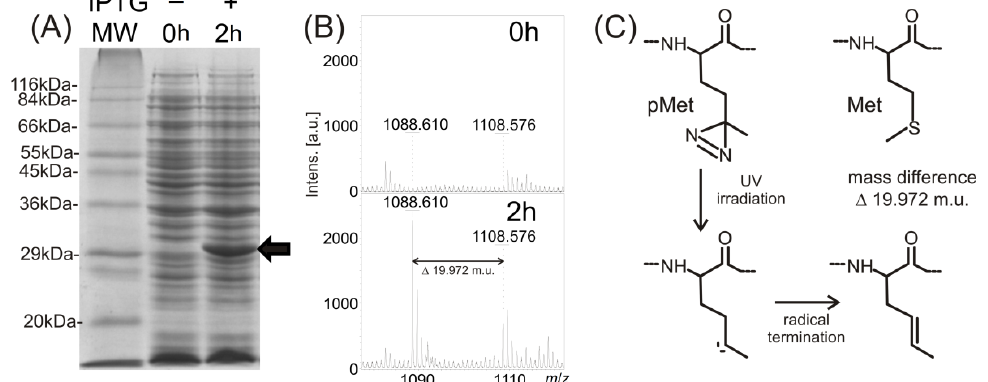
Figure 1. Monitoring of 14-3-3 ζ protein expression using 12% sodium dodecyl sulfate polyacrylamide gel electrophoresis (SDS-PAGE) ( A ); incorporation of the photo-labile analog of methionine by matrix-assisted laser desorption ionization-time of flight mass spectrometry (MALDI-TOF MS) ( B ), IPTG, β - D -1-thiogalactopyranoside; MW, molecular weight; a diagram of a reaction mechanism of photolysis ( C ). ( A ) SDS-PAGE of Sigma wide-range molecular weight standards, 14-3-3 ζ WT expression before induction (0 h) and after induction by β - D -1-thiogalactopyranoside (IPTG) and following incubation (2 h) (black arrow labels the 14-3-3 ζ WT, Coomassie Brilliant Blue R-250 staining); ( B ) MALDI-TOF MS monitoring of photo-labile methionine analog incorporation within 14-3-3 expressed protein after 0 and 2 h incubation; ( C ) schematic of the photo-methionine (pMet) photolysis reaction mechanism and the structural difference between its termination product and natural methionine